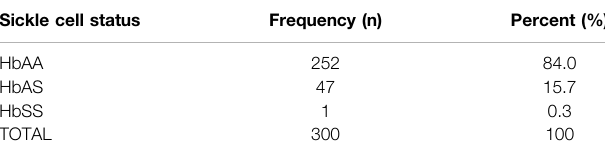
TABLE 2 | The prevalence of hemoglobin-S among pregnant women attending antenatal clinics in Dar-es-Salaam (N =